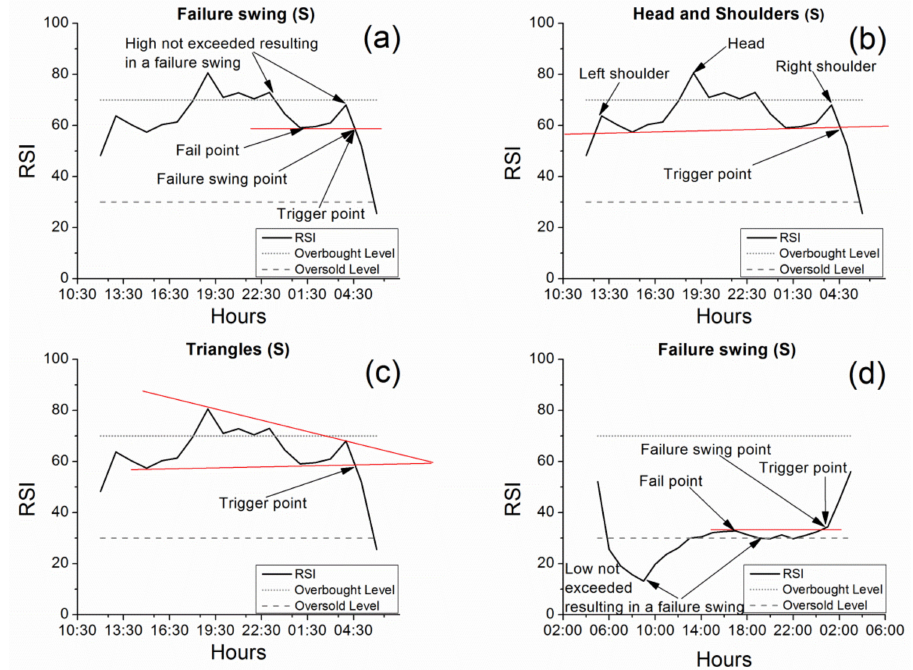
Figure 2. Detail of secondary features present in the areas of the RSI curve of Figure 1b which are marked by solid (detailed in ( a – c )) and dashed (detailed in ( d )) circles. The examined time period lies between 30 March 2001 12:00 (UT) and 1 April 2001 03:00 (UT). ( a , d ): The red line shows the failure swing point [84]. ( b ): The red line, which is called “neckline”, connects the lows of the two troughs between the three peaks. The line can slope up or down. The point at which the RSI value crosses the red line is often used as a final feature for the change of trend (“trigger point”) [84]. ( c ): The horizontal support line is an imaginary line that acts as support for the RSI values. Once RSI values are below this line, it resists any upward movement of the RSI values. The downward-sloping top trend line is an imaginary line that acts as a layer of resistance for the RSI values